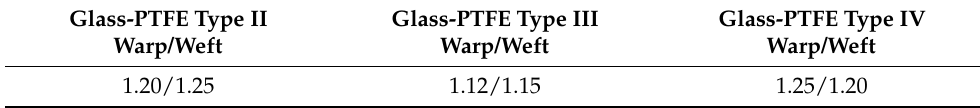
Table 7. Maximum strength modification factor k hum for considering the influence of humidity for different investigated types of glass-PTFE samples according to Table 3 under different water seepage